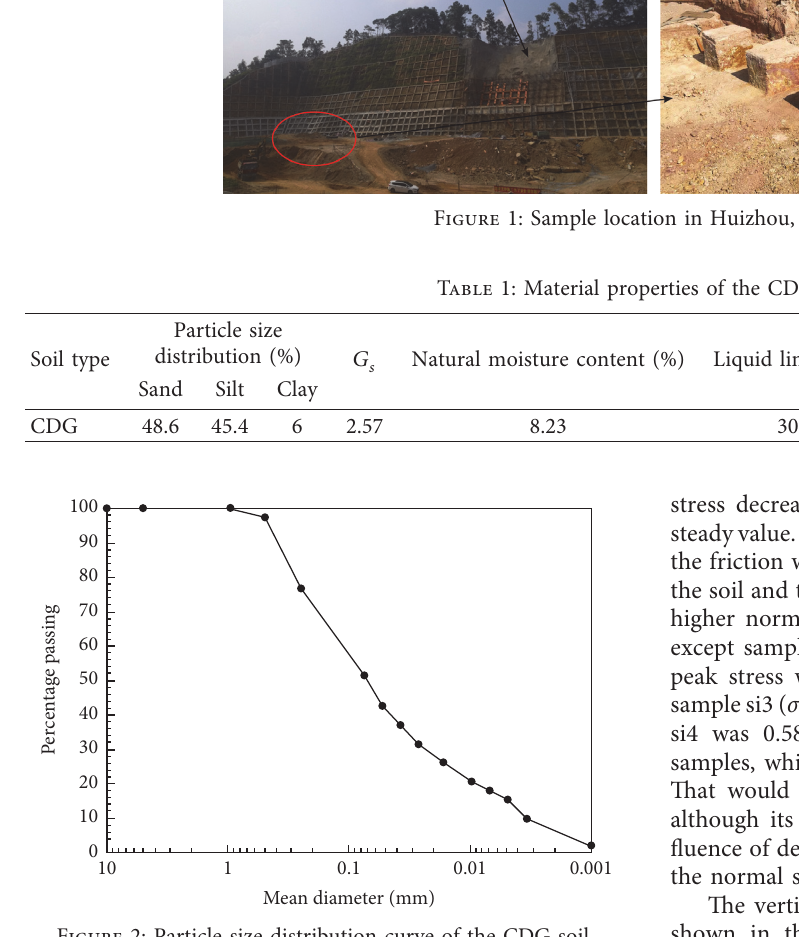
Figure 2: Particle size distribution curve of the CDG